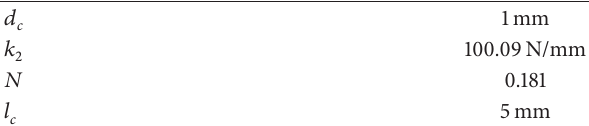
Table 5: Key structural parameters of the sample